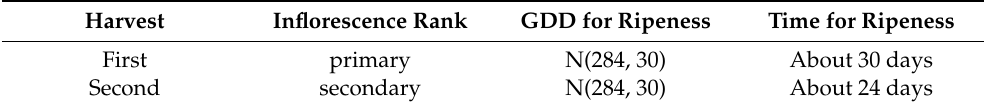
Table 2. Accumulated GDD requirements information.